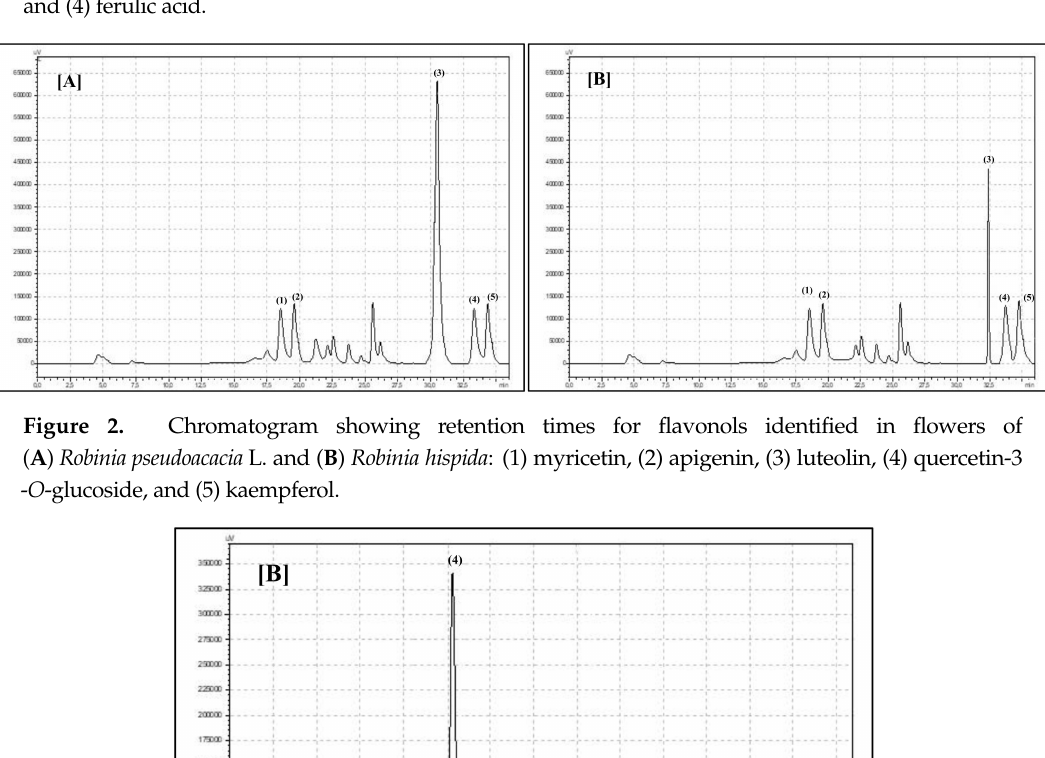
Figure 1. Chromatogram showing retention times for phenolic acids identified in flowers of ( A ) Robinia pseudoacacia L. and ( B ) Robinia hispida : (1) gallic acid, (2) chlorogenic acid, (3) caffeic acid, and (4) ferulic acid.